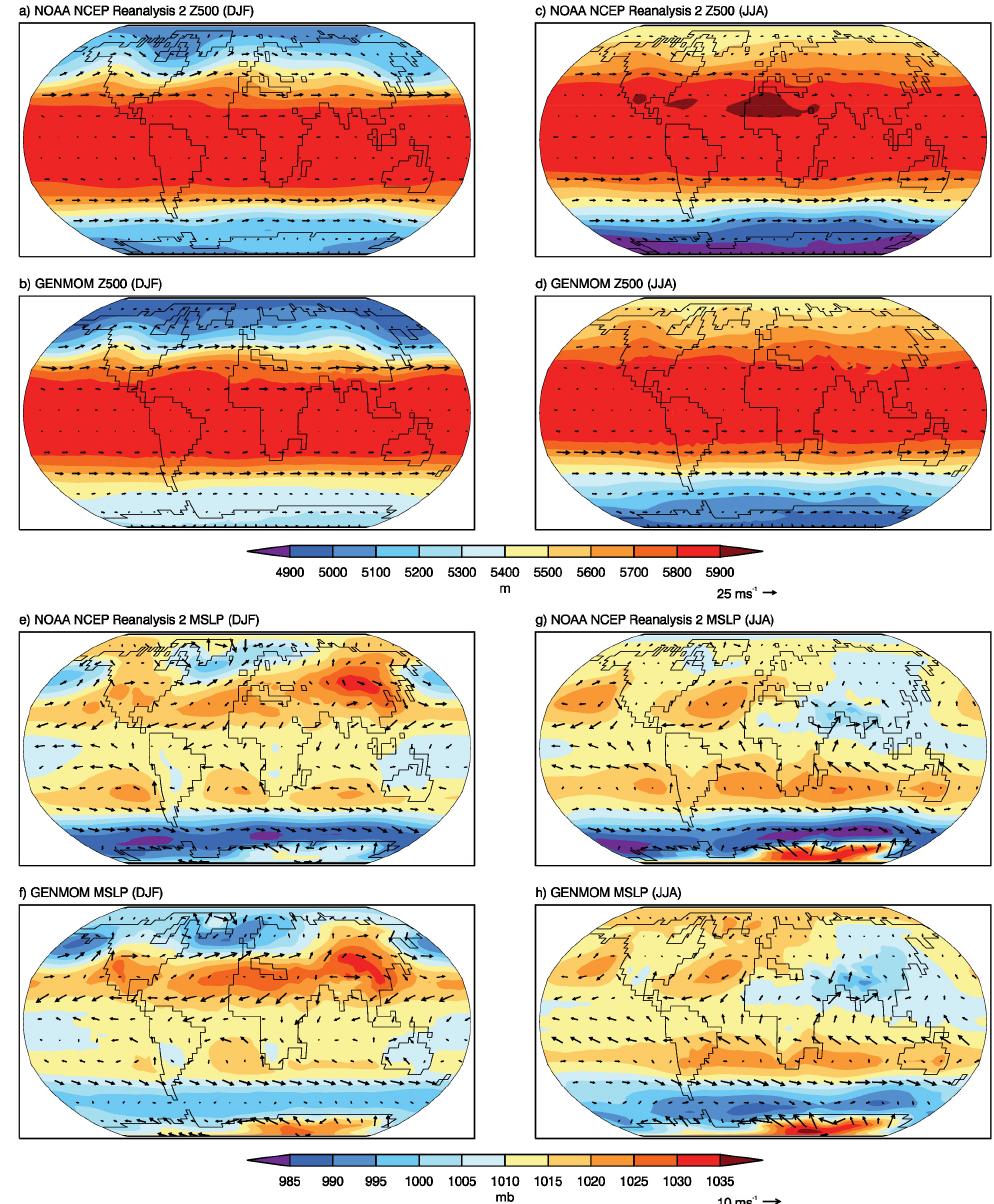
Fig. 3. 500hPa geopotential height (Z500, a–d ) and mean sea level pressure (MSLP, e–h ) with wind vectors for both winter (DJF) and summer